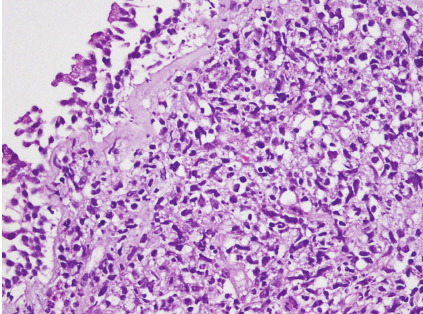
Figure 3: The figure demonstrates section belonging to bronchial mucosa. There is diffuse infiltration of atypical lymphoid cells under regular bronchial